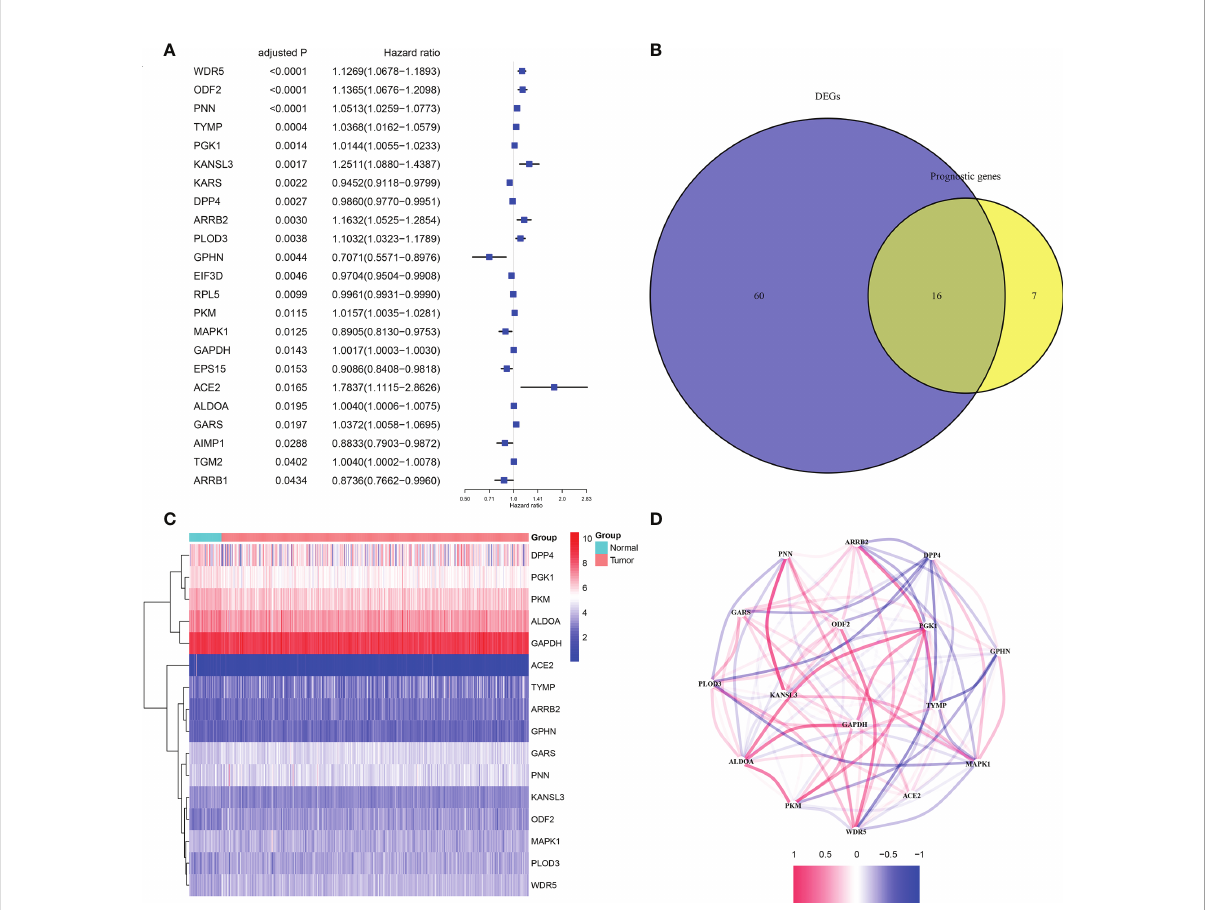
FIGURE 1 The candidate moonlighting genes in TCGA. (A) Univariate Cox regression analysis of PRAD for 23 prognostic moonlighting genes with P< 0.05. (B) Identi fi cation of mDEGs correlated with BFFS. (C) The expression of 16 prognosis-related mDEGs between normal and tumor samples. (D) The correlation network of 16 candidate